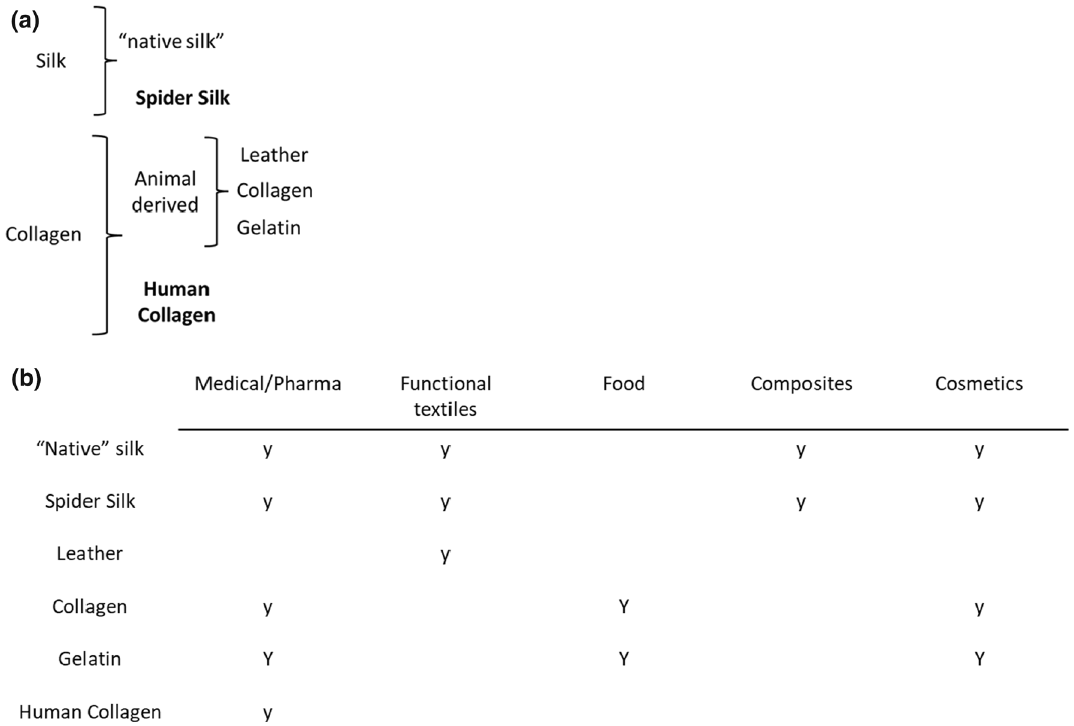
Fig. 1 Schematic representation of various types of silk and collagen. a In bold font, the molecules that are the focus of this review. b The most relevant industrial uses of silk and collagen and collagen-related materials. “Y” indicates use of the biomaterial in that